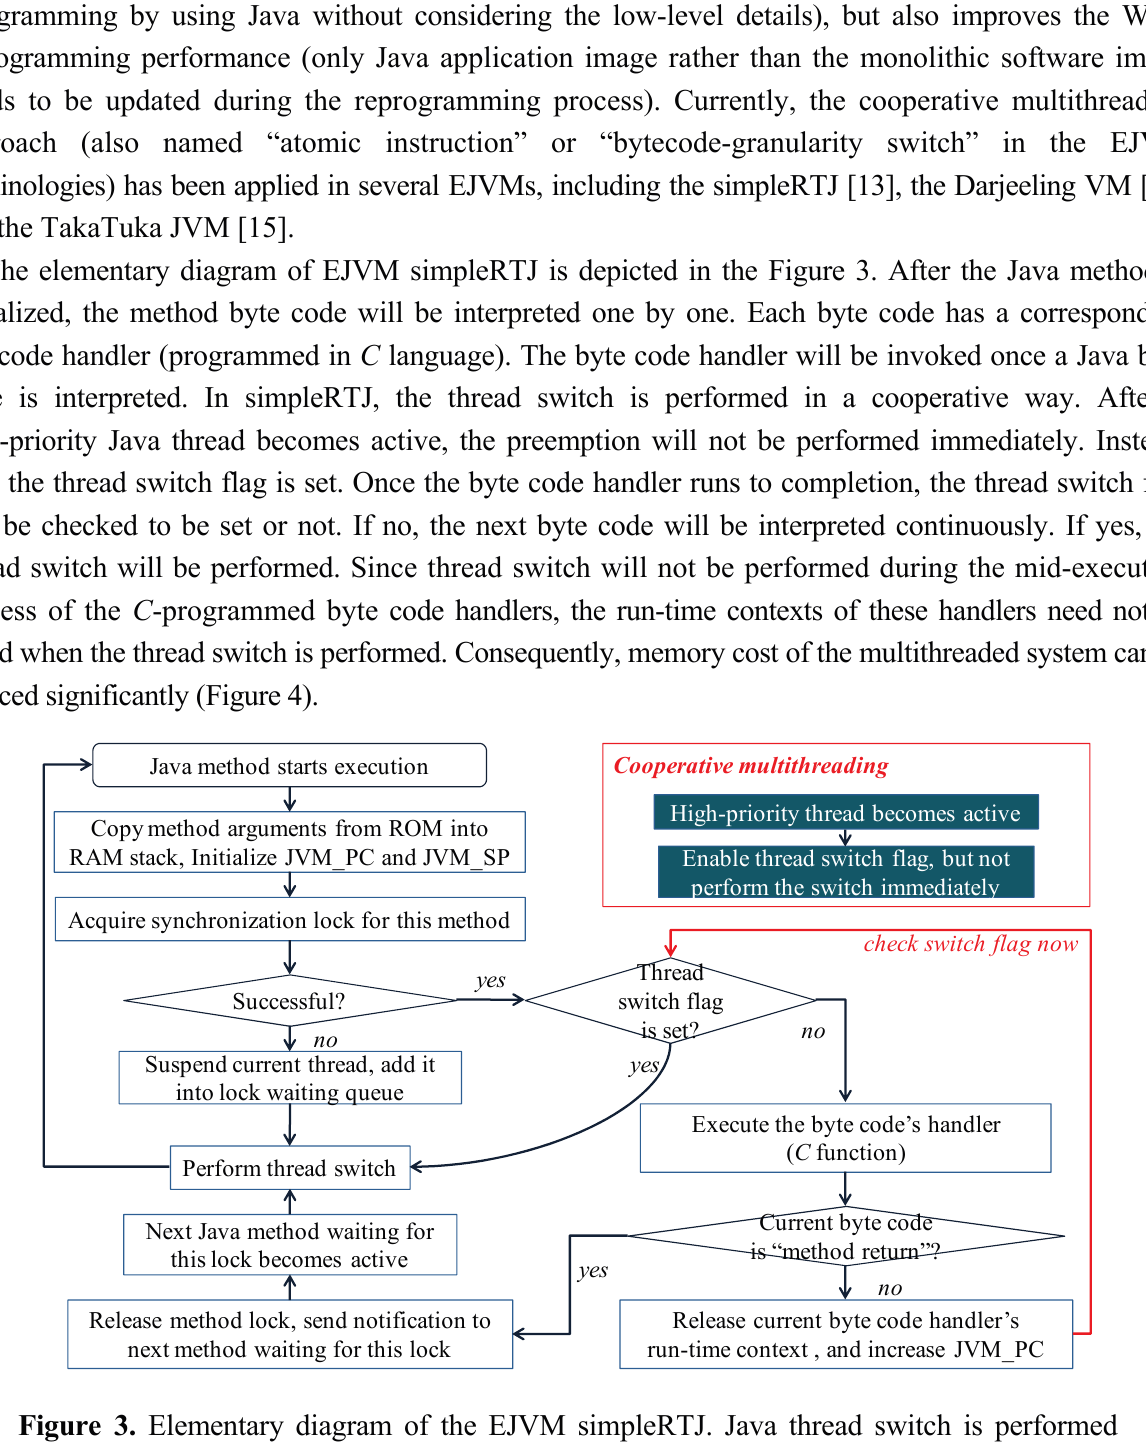
Figure 3. Elementary diagram of the EJVM simpleRTJ. Java thread switch is performed cooperatively in simpleRTJ. Only after the byte code’s handler runs to completion and releases its run-time context, can the Java thread switch be